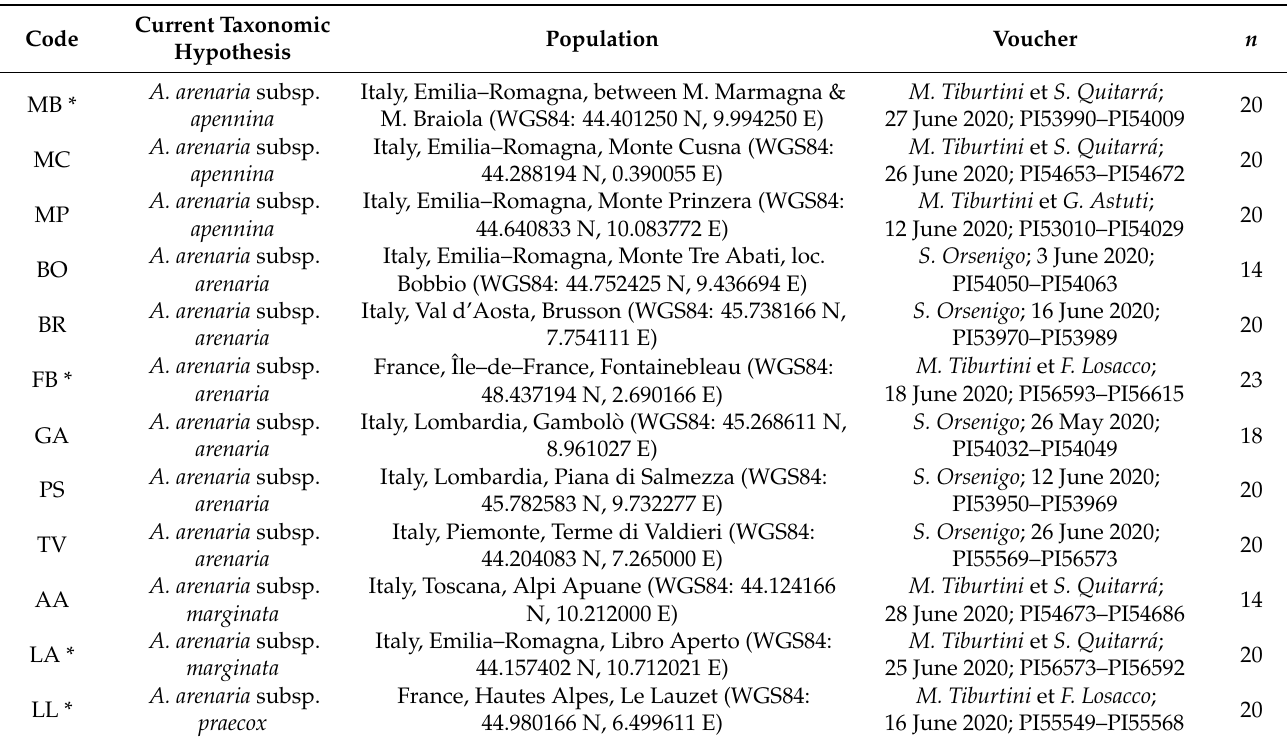
Table 1. Taxa and populations of Armeria arenaria sampled in this study, according to the current taxonomic hypothesis [17]. “Code” corresponds to population acronyms used elsewhere in the manuscript. * = type locality. “Voucher” refers to the specimens stored at Herbarium Horti Botanici Pisani (PI) and freely available for consultation at http://erbario.unipi.it/, accessed on 10 July 2022. See also Figure 6 for the geographical localisation of the sampled